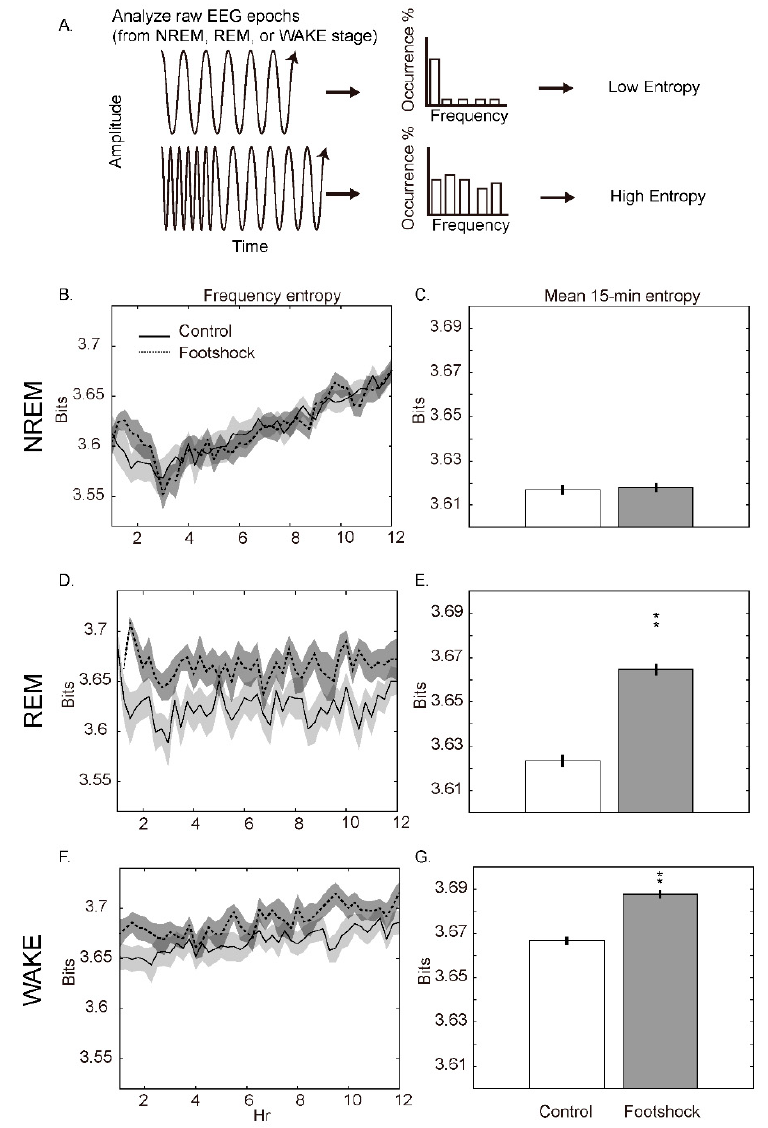
Figure 4. Comparison of the frequency entropy after the footshock stimuli. ( A ) Uniform frequencies of EEGs result in a low entropy, whereas the variety of frequencies causes an uncertainty of the occurrence rate and results in a high entropy. ( B ) Distribution of frequency entropy for NREM sleep. The solid line and light gray shadow represent the values of means ± SEMs for every 15 min during the light period, obtained from the control group. The dashed line and dark gray shadow are the results acquired from the footshock group. ( C ) Statistical significant test for the frequency entropy. The white bar is the value of mean ± SEM for 15 min bins across the total 12 h light period, obtained from the control group, and the gray bar represents the frequency entropy acquired from the footshock group. ( D , E ) Represented the data for REM sleep. ( F , G ) Demonstrated the results for wakefulness. ** Indicates the difference reaches statistical significance of p < 0.01.